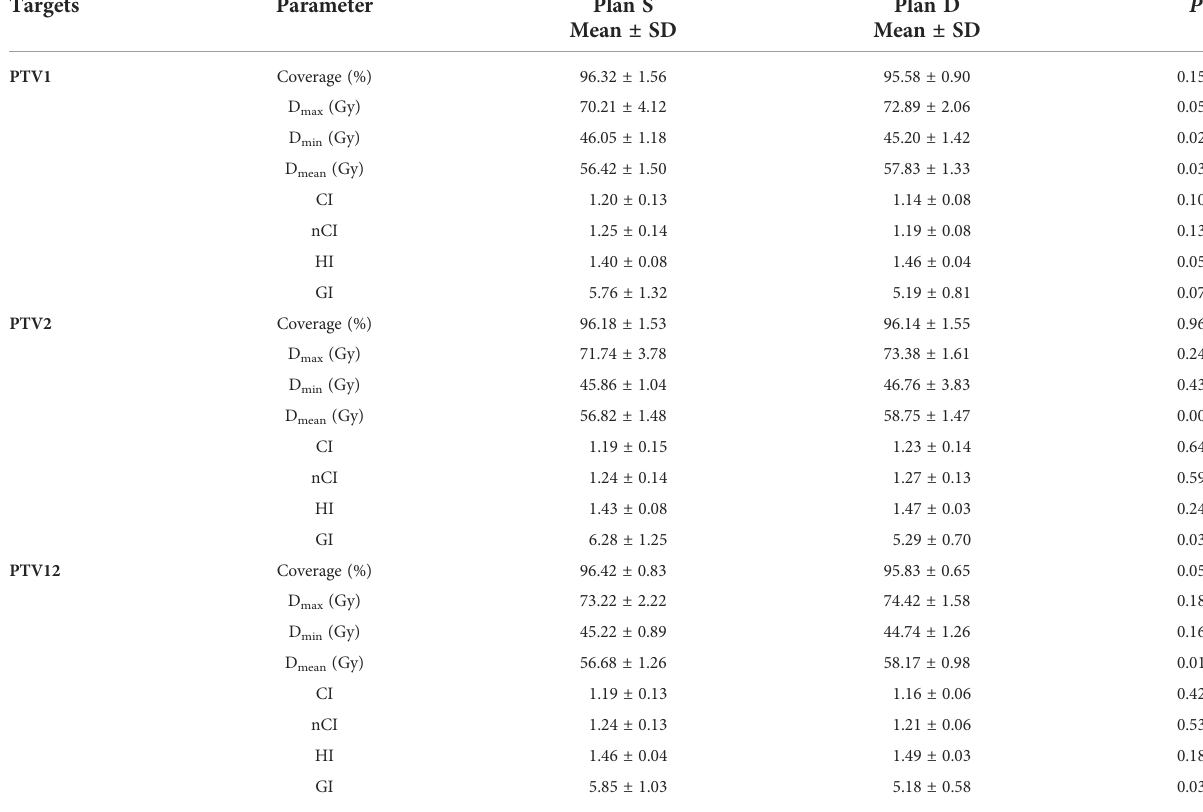
TABLE 3 Comparisons of dosimetric parameters for different PTVs in synchronous bilateral lungs.